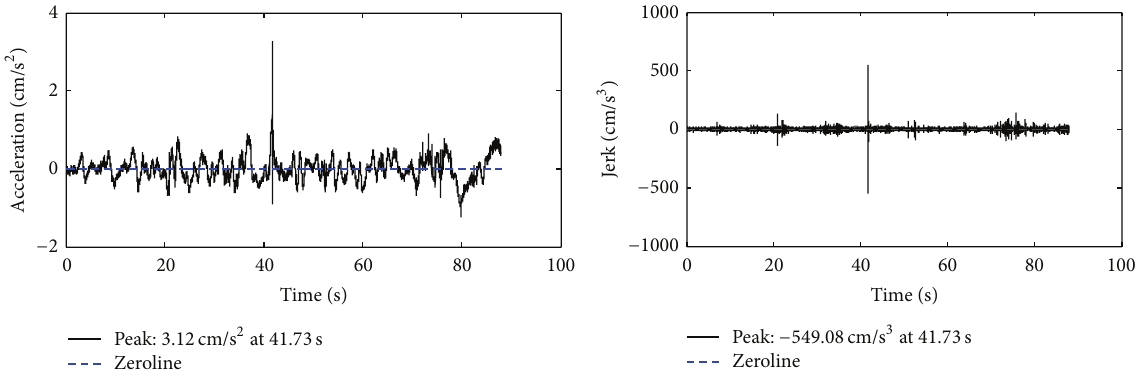
Figure 3: Acceleration time history and Jerk time history (032XPX080512142802).